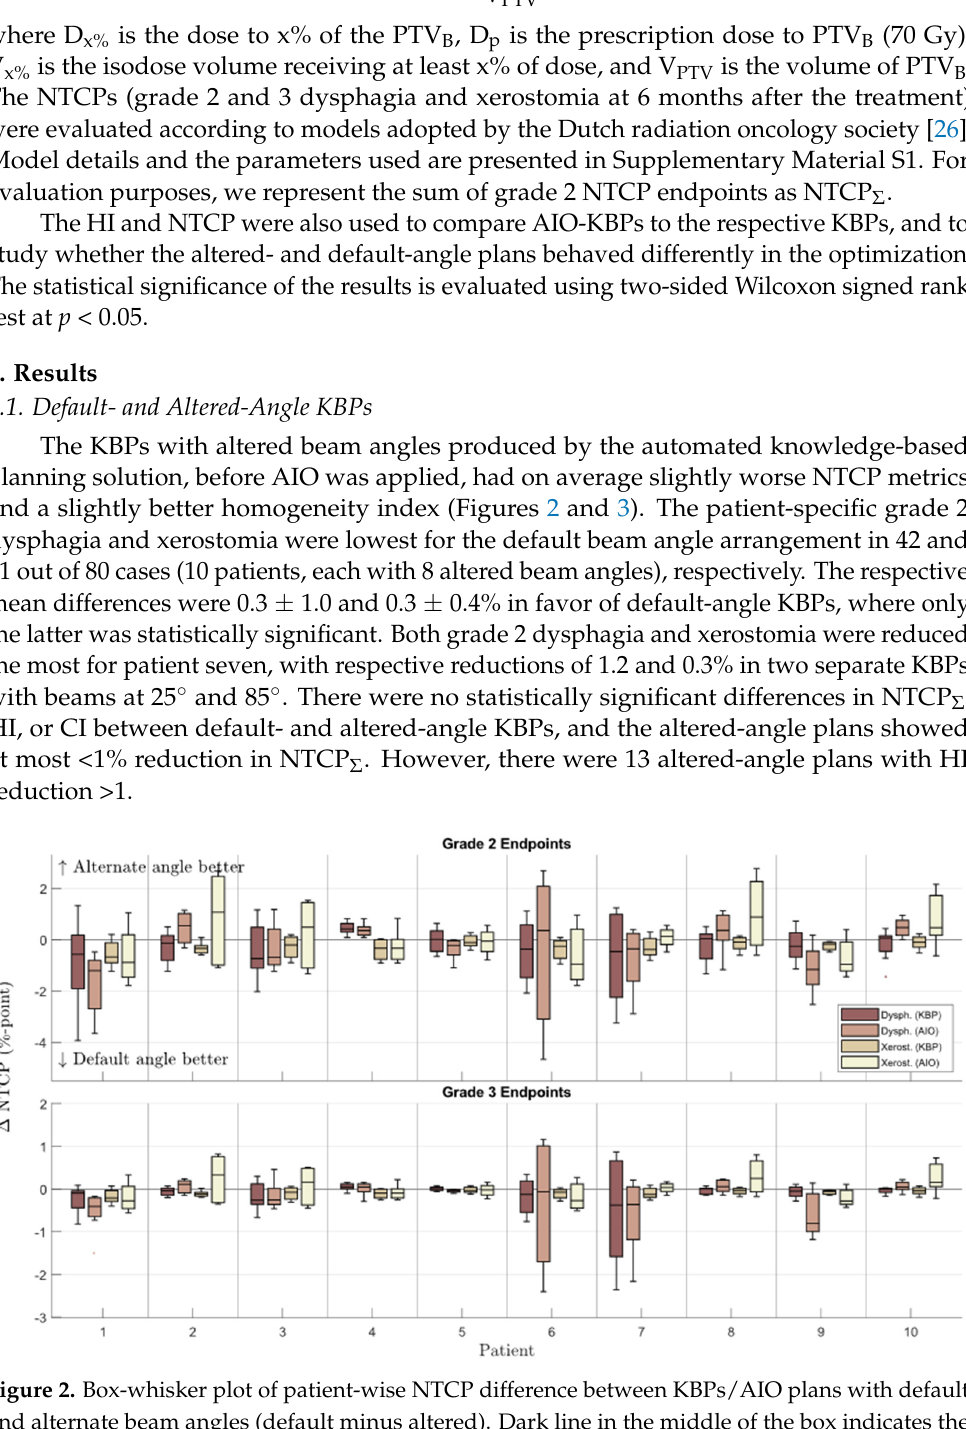
Figure 3. Difference in the sum of grade 2 NTCP endpoints and HI between KBPs with default and alternate beam angles (default minus altered). ∆ NTCP Σ = difference in the sum of grade 2 normal tissue complication probabilities; KBP = knowledge ‐ based plan; AIO = automatic iterative opti ‐ mizer ‐ generated plan.